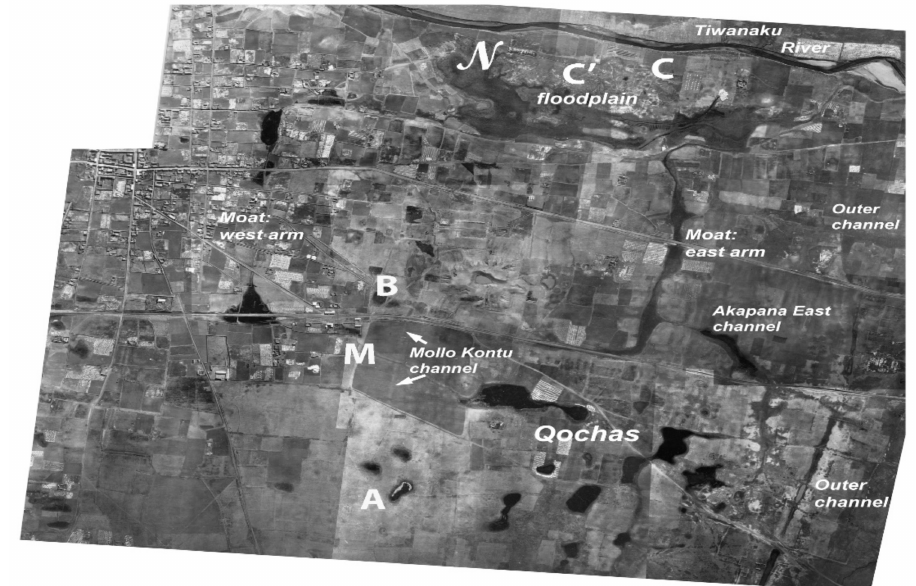
Figure 2. Aerial photograph view of the inland perimeter drainage channel (denoted above as the Moat) surrounding the ceremonial core of Tiwanaku indicating the intersecting Mollo Kontu M canal, qocha regions and the Tiwanaku River to the